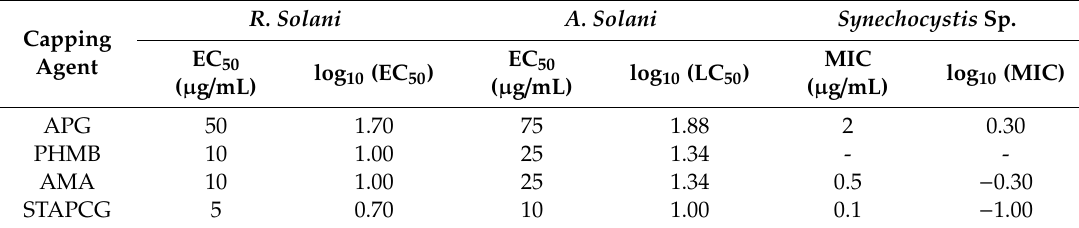
Table 8. Toxicity characteristics of silver NP dispersions with respect to R. solani , A. solani and Synechocystis sp.